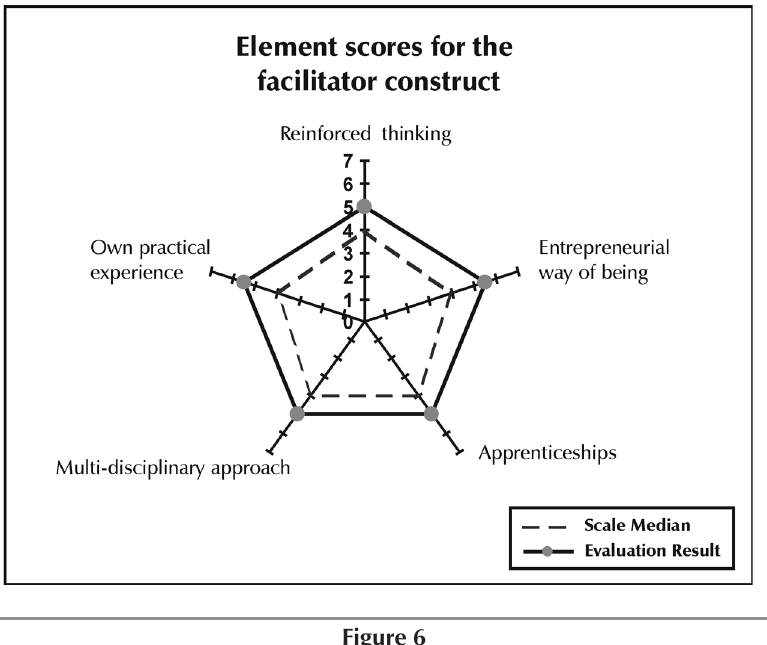
Graphical representation of evaluation results for the elements of the facilitator construct of the NVCL compared to the midpoint